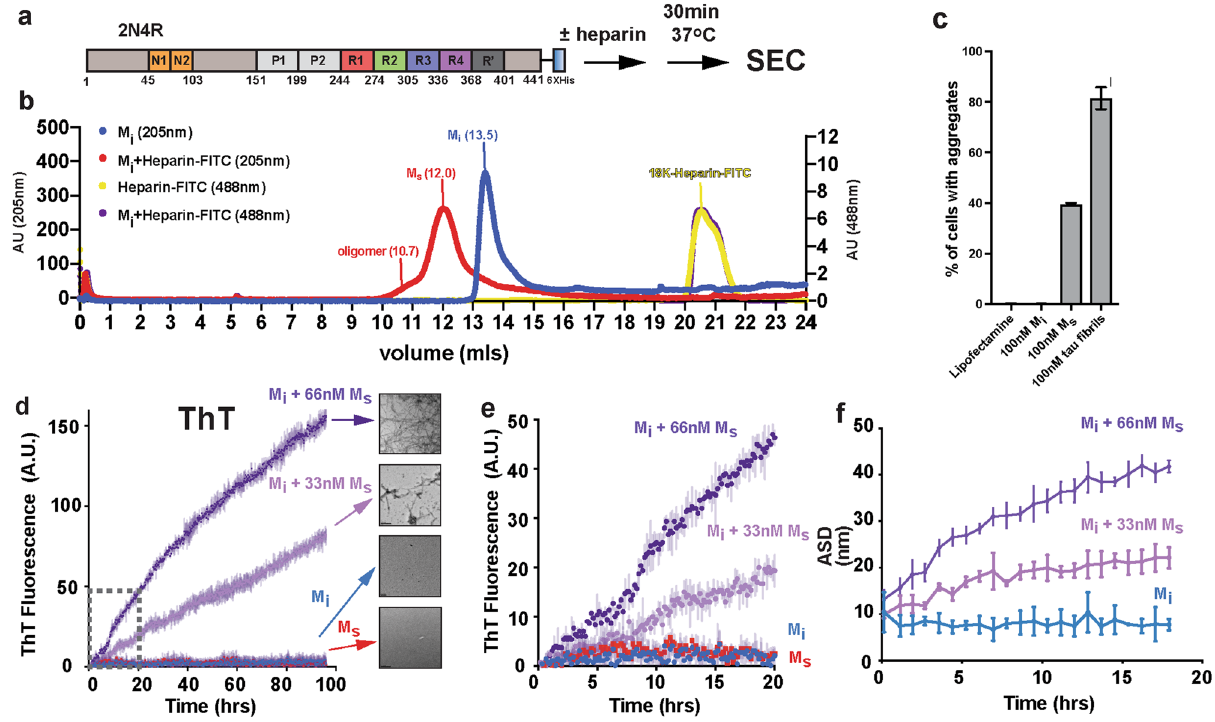
Figure 1. Generation and characterization of recombinant tau seeds. ( a ) Schematic for tau seed production. Full-length 2N4R tau was incubated with heparin for 30 min and resolved by SEC. 2N4R tau is shown as a cartoon schematic. The N1 and N2 domains are colored in orange. The repeat domains are colored in red, green, blue, magenta and dark grey. The proline-rich P1 and P2 domains are colored in light grey. ( b ) SEC chromatograph of tau, tau:heparin-FITC, heparin-FITC reactions resolved on a Superdex 200 10/300 GL increase column. The tau alone and tau:heparin-FITC traces acquired using Absorbance at 205nm are colored in blue and red, respectively. The heparin-FITC and tau:heparin-FITC traces acquired using Absorbance 488nm are colored in yellow and purple, respectively. ( c ) Activity of SEC fractions in a tau biosensor seeding assay. Lipofectamine alone and tau fibrils were used as negative and positive controls, respectively. Experiments were performed in triplicate showing average values with standard deviation. ( d ) ThT fluorescence aggregation assay comparing 4uM M i (blue), 66 nM M s alone (red), 4uM M i + 33 nM M s (light magenta), 4uM M i + 66 nM M s (purple). Representative TEM images of M i , M s , M i + 33 nM M s and M i + 66 nM M s samples imaged at the end point of each reaction. Fibrils were not observed in the M i alone condition. Each experiment was performed in triplicate and is shown as an average with standard deviation. Grey dotted box highlights the data for the early 20 h time point for comparison with DLS data. ( e ) Zoom in of ThT fluorescence aggregation experiment from ( d ) within 20 h allowing direct comparison of the fluorescence signal to the DLS experiment in ( f ). Curves are colored as in ( d ). (f) DLS time-course of seeded M i aggregation. Average size distribution (ASD) of triplicate 4uM M i alone (blue), 4uM M i + 33 nM M s (light magenta) and 4uM M i + 66n (purple). 66 nM M s alone was not included because it was to dilute to observe by scattering. DLS experiment was carried out in triplicate and the data are shown as averages with standard